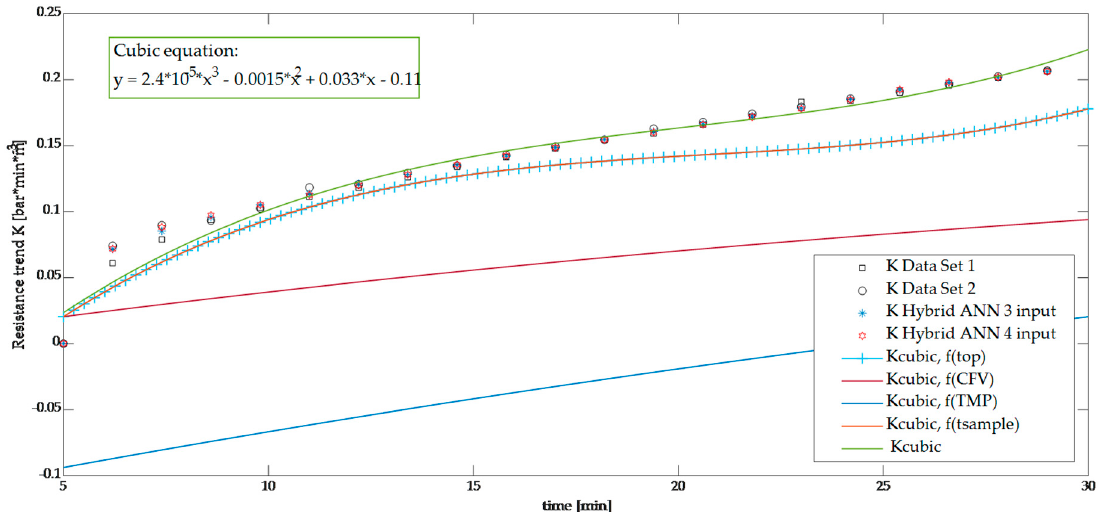
Figure 8. K -resistance trends, both experimental and hybrid. The cubic interpolation between them and the dependency of each variable with cubic K